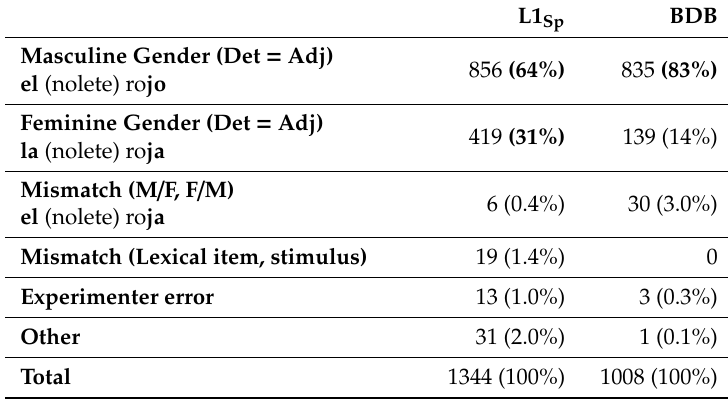
Table 3. Distribution of participants’ responses across types ( n and